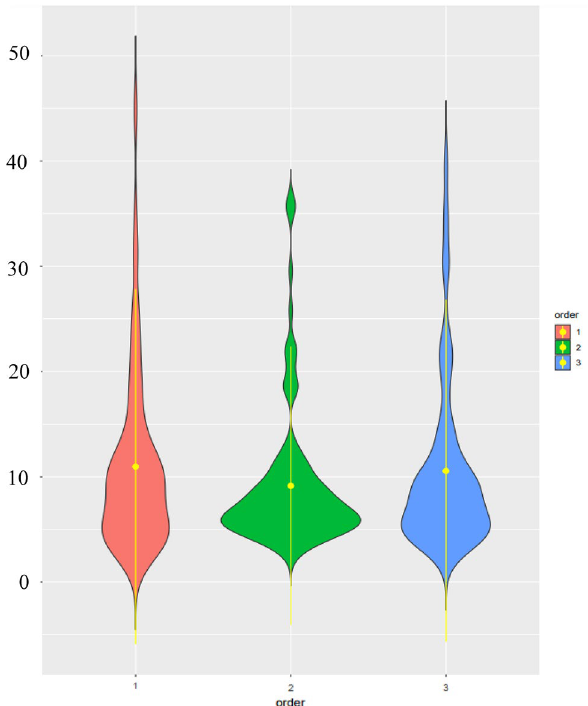
Figure 2. Violin plots showing the distribution of cysts count in Y1 (red), Y2 (green) and combined year data analysis CY (blue). In each case, the vertical solid bar indicates the range of average values, and median is shown as a white circle, depicting the lower, medium and upper